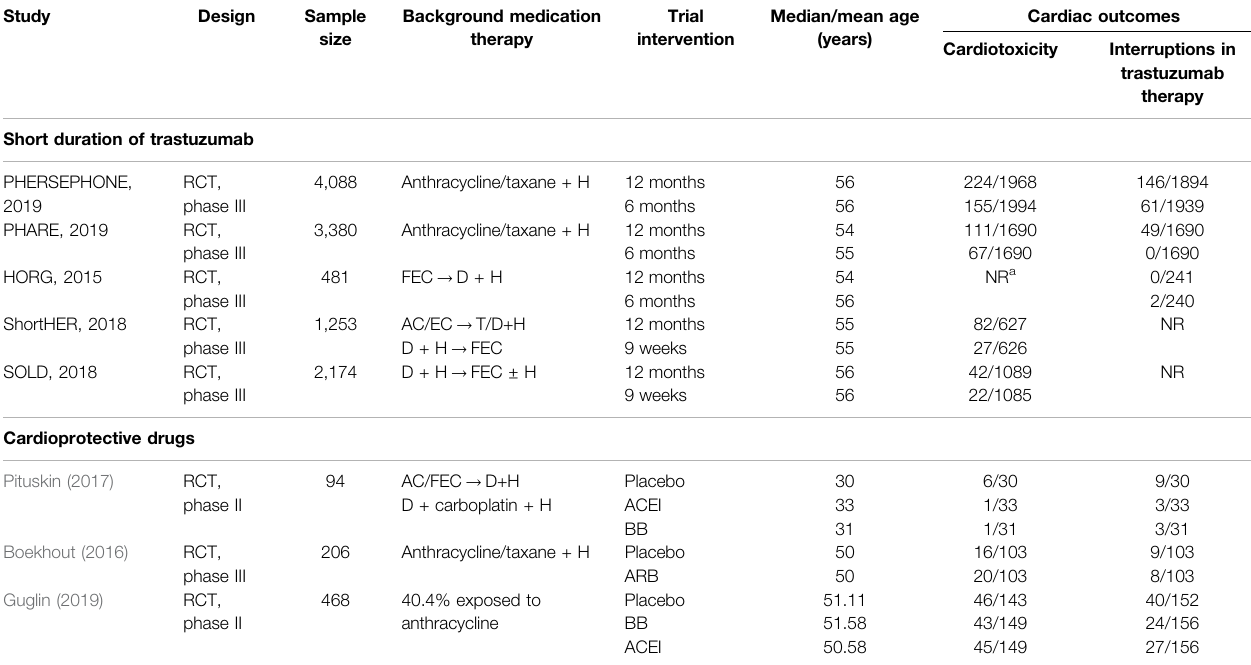
TABLE 1 | Study characteristics of eligible